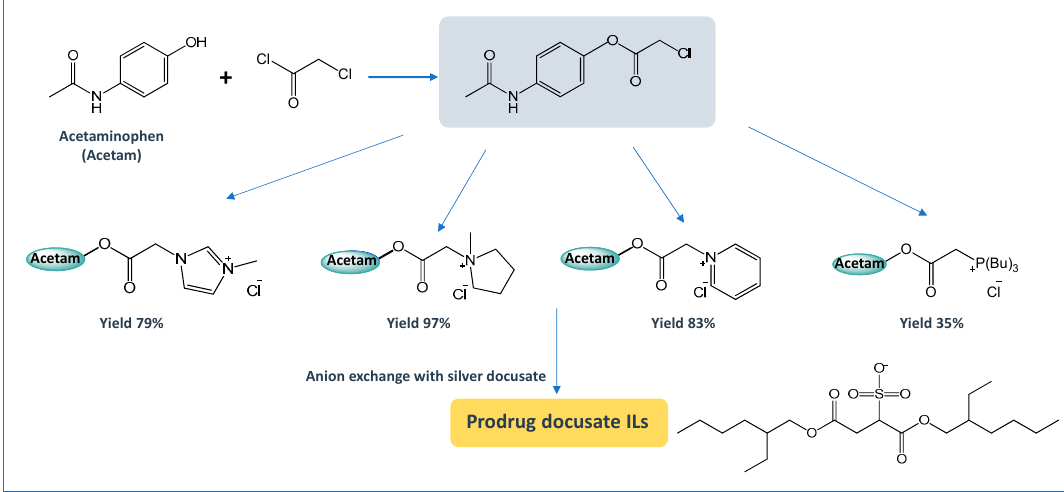
Figure 14. Synthesis of cationic acetaminophen prodrug ILs paired with the docusate anion proposed in [158].